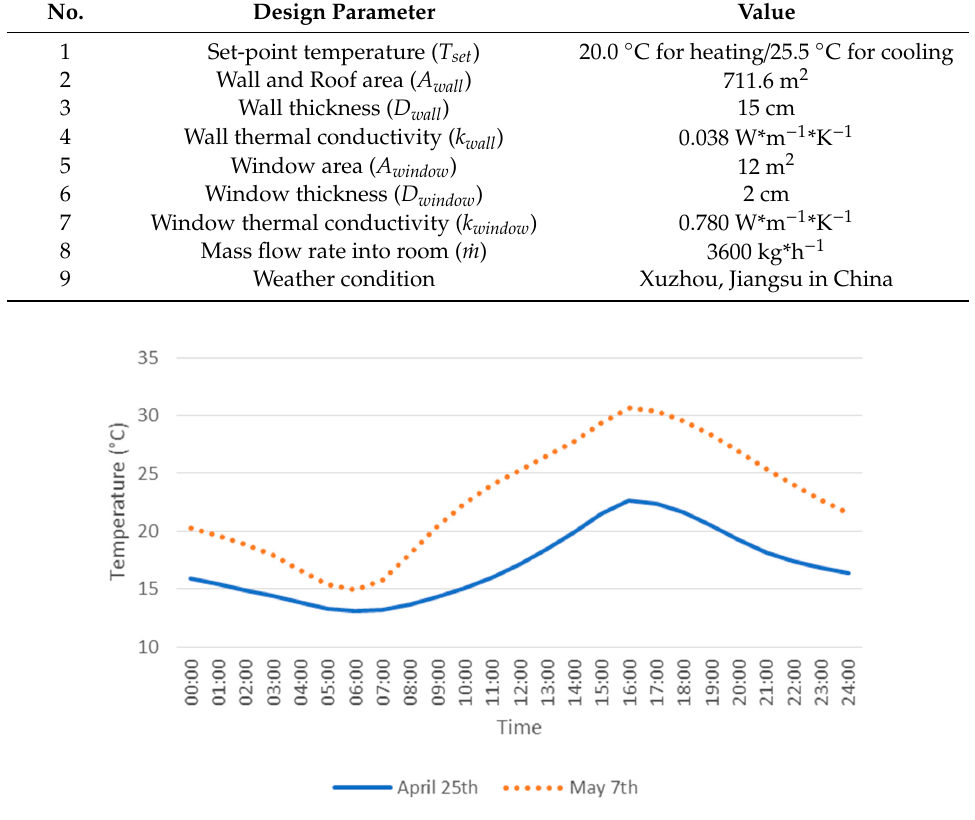
Figure 2. Outdoor temperature of April 25th and May 7th.